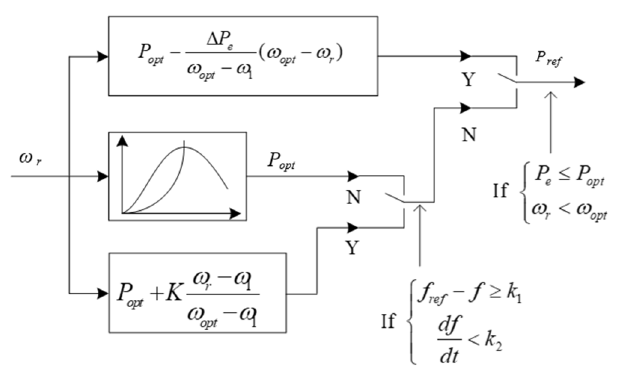
ω opt P Figure 2. The relationship between rotor speed and output power of DFIG.